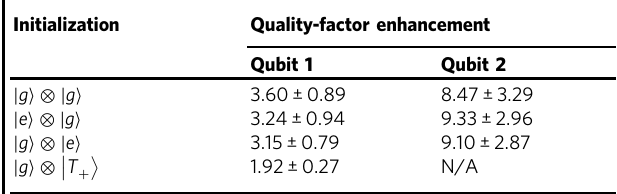
Table 1 Quality-factor enhancements of both qubits for different initial